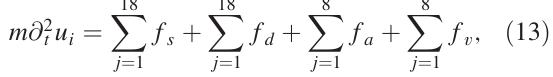
isotropic linear elasticity with Lam`e constants λ ¼ μ ¼ k=a